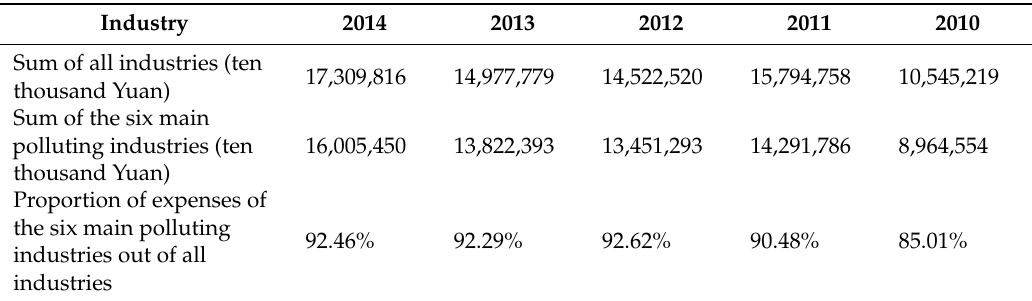
Table 3. Annual operating expenses of waste gas treatment facilities in the six high-pollution industries from 2010 to